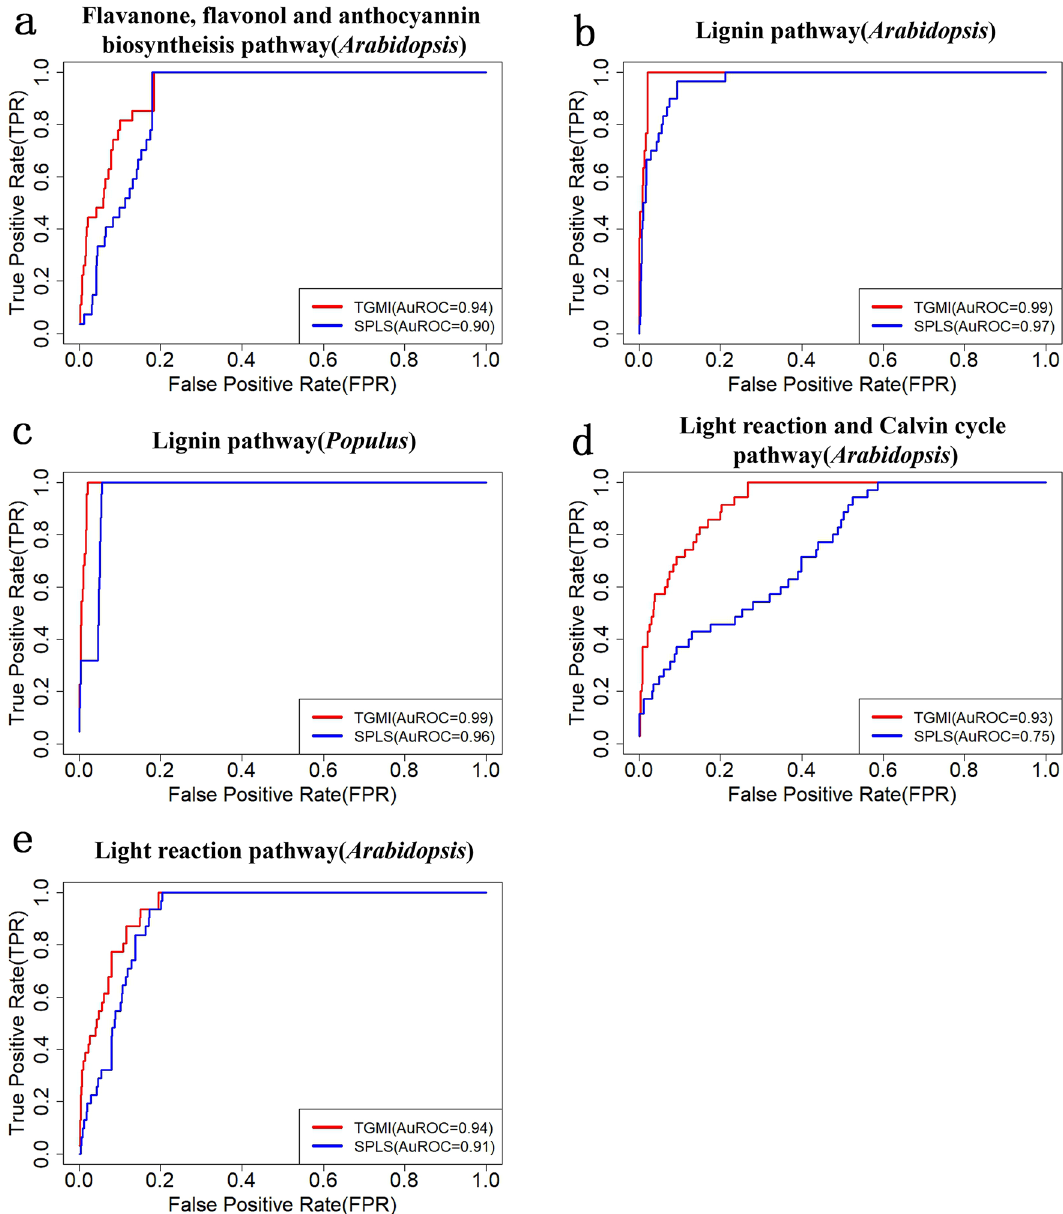
Figure 8. The receiver operating characteristics (ROCs) of TGMI and SPLS algorithms in recognition of pathway regulators. The ROC curves that closely follow the TPR axis, and then the top FPR axis represent the higher sensitivity in identifying positive regulators. The area under the ROC curve (AUROC) was also calculated to show which methods had high higher sensitivity versus 1-specificity in correctly ranking the candidate regulatory pathway genes 70,71